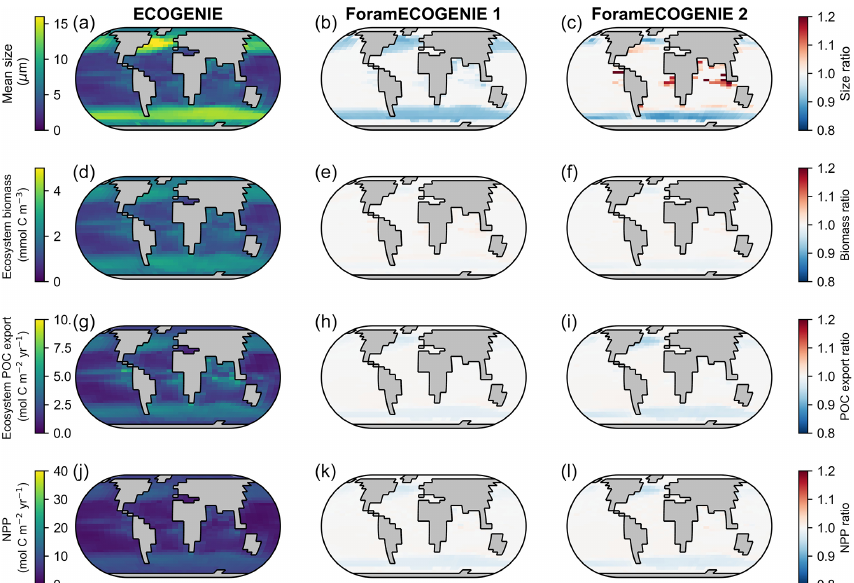
Figure 10. Comparison of the tuned ForamEcoGEnIE 2.0 (third column, with four foraminiferal groups) with EcoGEnIE (first column; Ward et al., 2018) and ForamEcoGEnIE 1.0 (second column, with non-spinose non-symbiont foraminifera only; Grigoratou et al., 2021a) for (a–c) total plankton mean size, (d–f) total plankton biomass, (g–i) total POC export, and (j–l) net primary production (NPP). The first column displays absolute values while the latter two show the ratio relative to the first